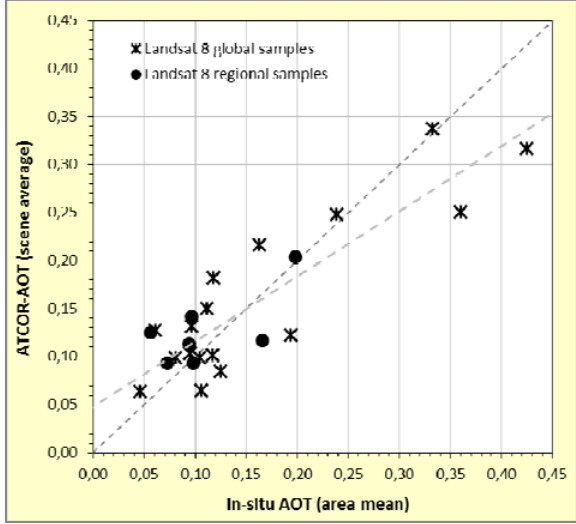
Figure 7. AOT estimated from satellite data using ATCOR compared with in situ-AOT for the global data set. The grey, long-dashed line is the linear trend through the data